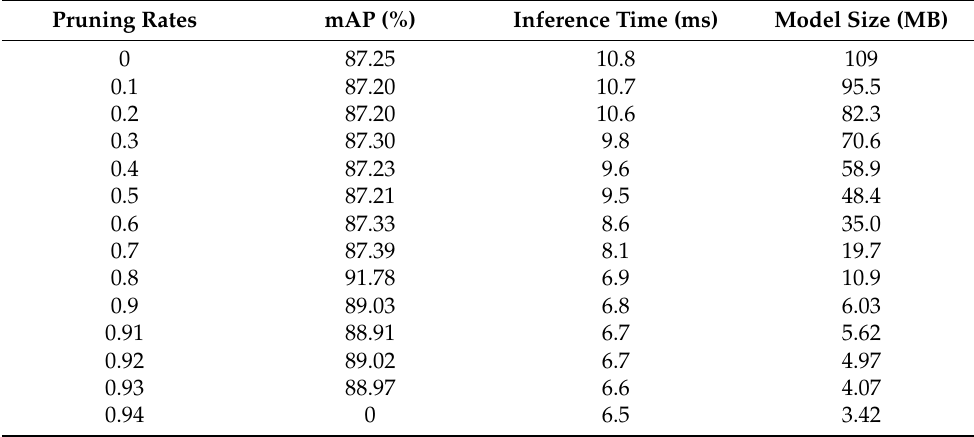
Table 1. The comparison of different pruning rate parameters.